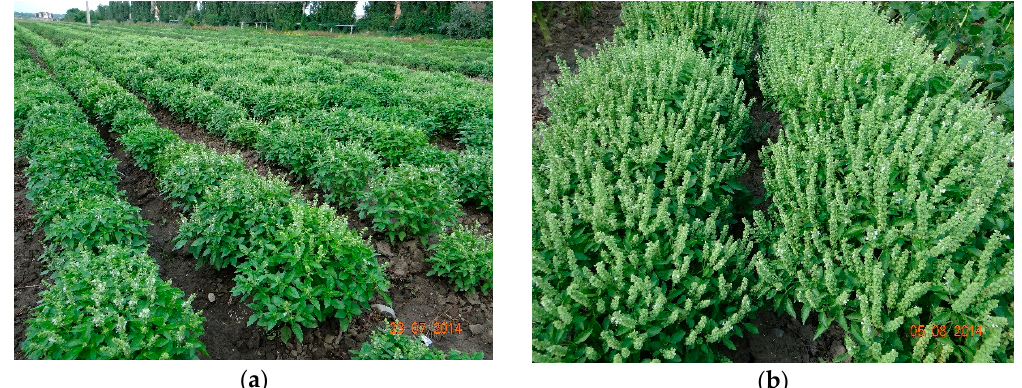
Figure 1. O. basilicum hybrids: “Aromat de Buzau” ( a ) “Macedon” ( b ).